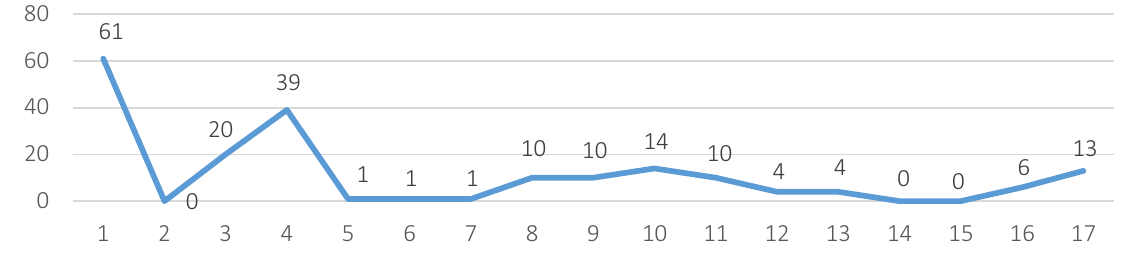
Figure 2. Number of SR practices of HEIs in Poland under the SDGs